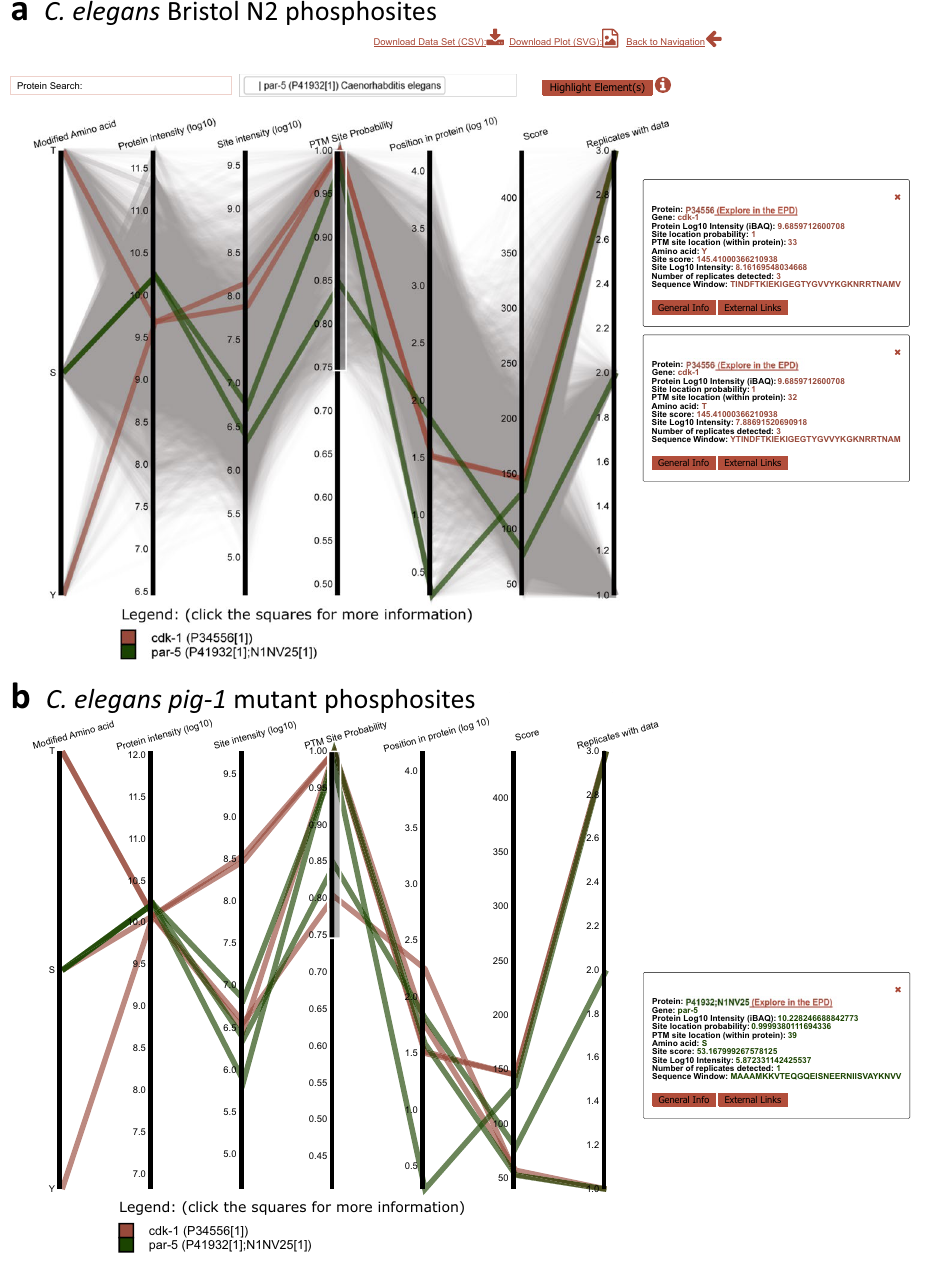
Figure 6. Phosphosites detected in wild-type and pig - 1 mutant embryos. ( a ) Detected protein post translational modification (PTM) phosphorylation sites in wild-type embryos. Each grey line represents a phosphorylation site and models its behaviour across multiple dimensions. The phosphorylation lines intersect the y-axes on the values that were detected for the specific site. The axis dimensions are ‘modified amino acid’ (threonine (T), serine (S) or tyrosine (Y)), ‘protein intensity’ (in log 10 scale), ‘site intensity’ (in log 10 scale), ‘PTM site probability’, ‘position in protein’ (in log 10 scale), ‘score’ (of identification, the product of all peptide posterior error probabilities used for identification that is calculated in MaxQuant), and number of ‘replicates with data’. ( b ) Detected protein phosphorylation sites of two example proteins in pig - 1 mutant embryos - the grey lines for background phosphorylation were removed in this graph. Both of these plots are available online as interactive visualisations via the EPD (http://www.peptracker.com/epd/). Firstly, the axes can be filtered such that only elements contained within the user-defined boxes are shown: in the depicted graphs an example filter of ≥ 0.75 was applied for the ‘PTM site probability’ axis. Secondly, proteins can be searched and their phosphorylation sites can be highlighted in colour: Here, this was done for the same two example proteins and the search bar is shown on top of one of the graphs. Thirdly, selection of a phosphorylation line will lead to the display of a tooltip box containing further information: In the graphs shown, this was done for three examples of phosphorylation